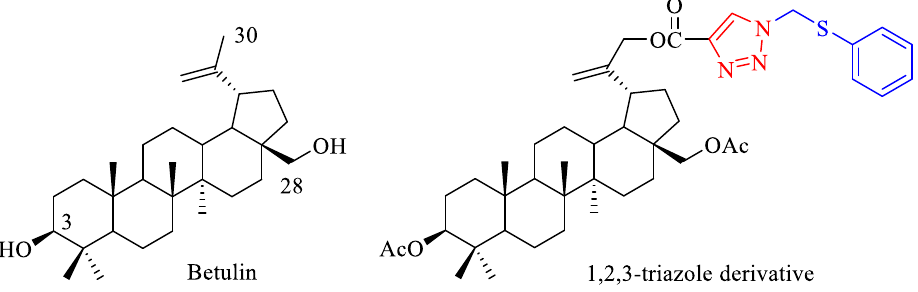
Figure 1. Chemical structure of betulin and 1,2,3-triazole derivative of 3,28- O , O ′-diacetylbetulin.